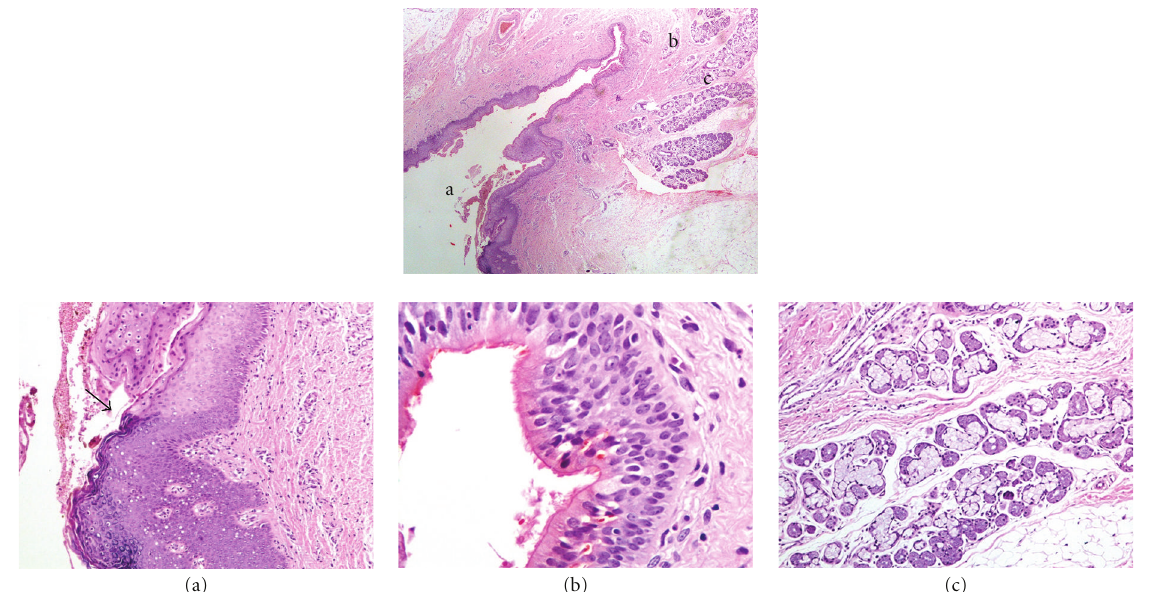
Figure 5: (Top panel) Low power view of the caudal duct ( × 2). The letters a, b and c represent the foci shown in magnification (a), (b), and (c), respectively (hematoxylin-eosin stain). (a) shows the transition (arrow) between normal epidermis displaying granular layer and orthokeratosis to the parakeratotic squamous epithelium lining the duct ( × 10, hematoxylin-eosin stain). (b) The lower portion of the blind duct is lined by pseudostratified ciliated epithelium, upper respiratory type ( × 40, hematoxylin-eosin stain). (c) The duct is surrounded by seromucinous glands ( × 10, hematoxylin-eosin stain).